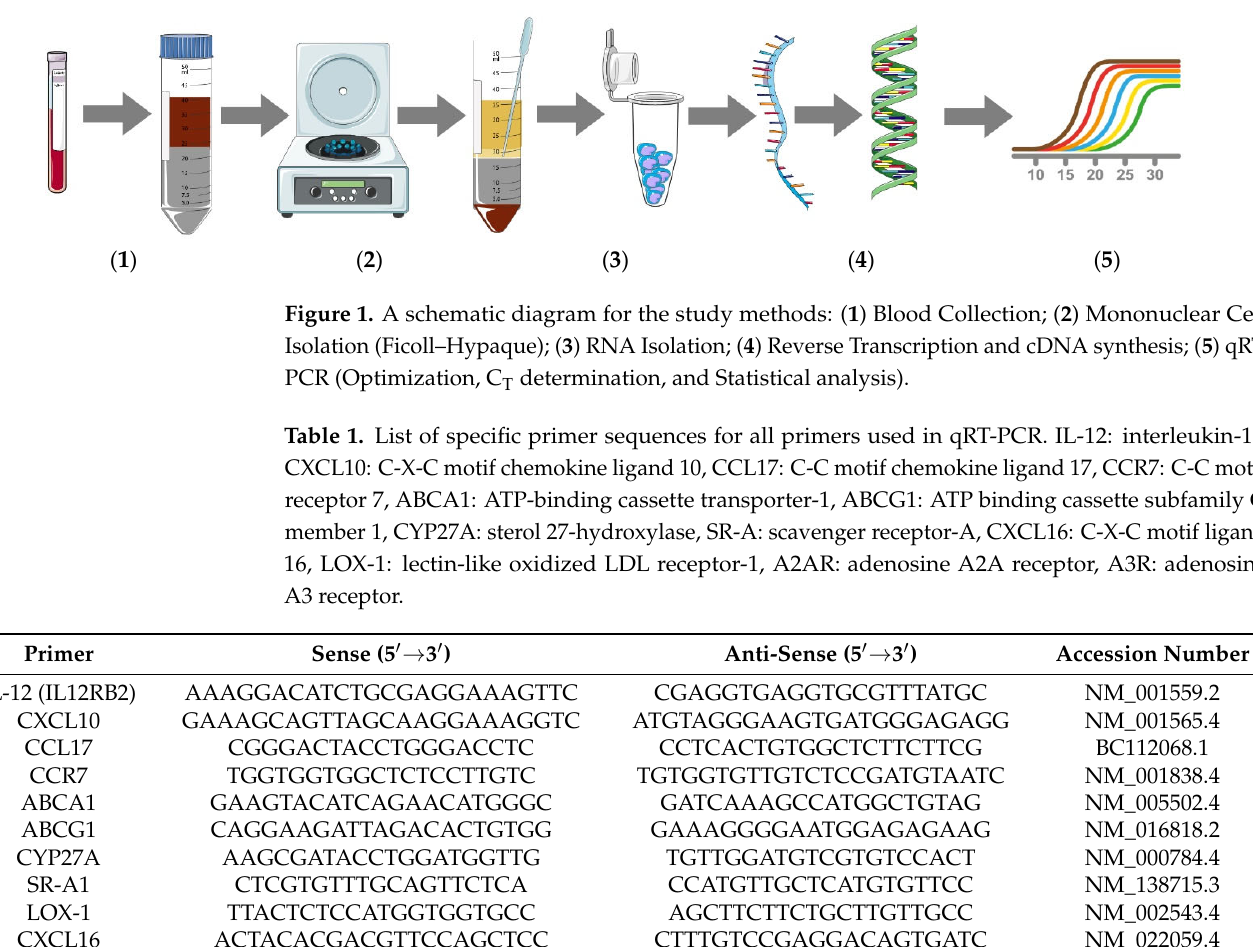
Table 1. List of specific primer sequences for all primers used in qRT ‐ PCR. IL ‐ 12: interleukin ‐ 12,